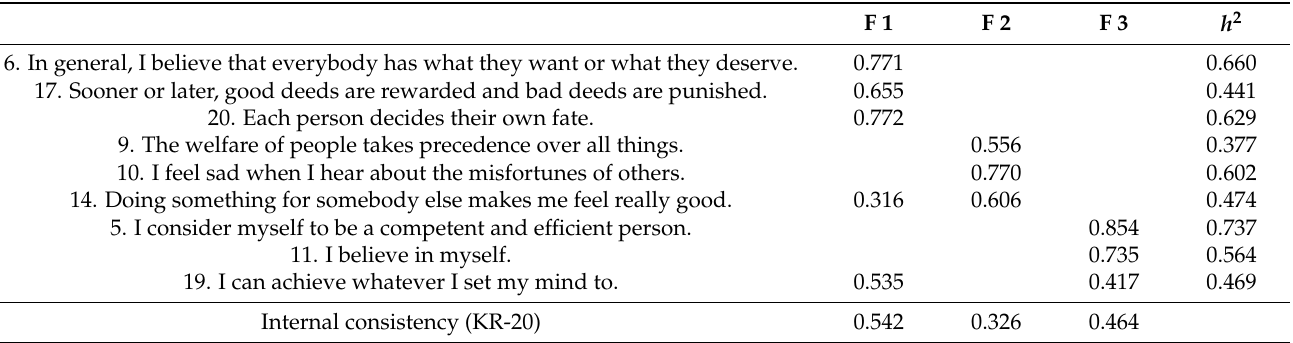
Table 2. Factorial structure of